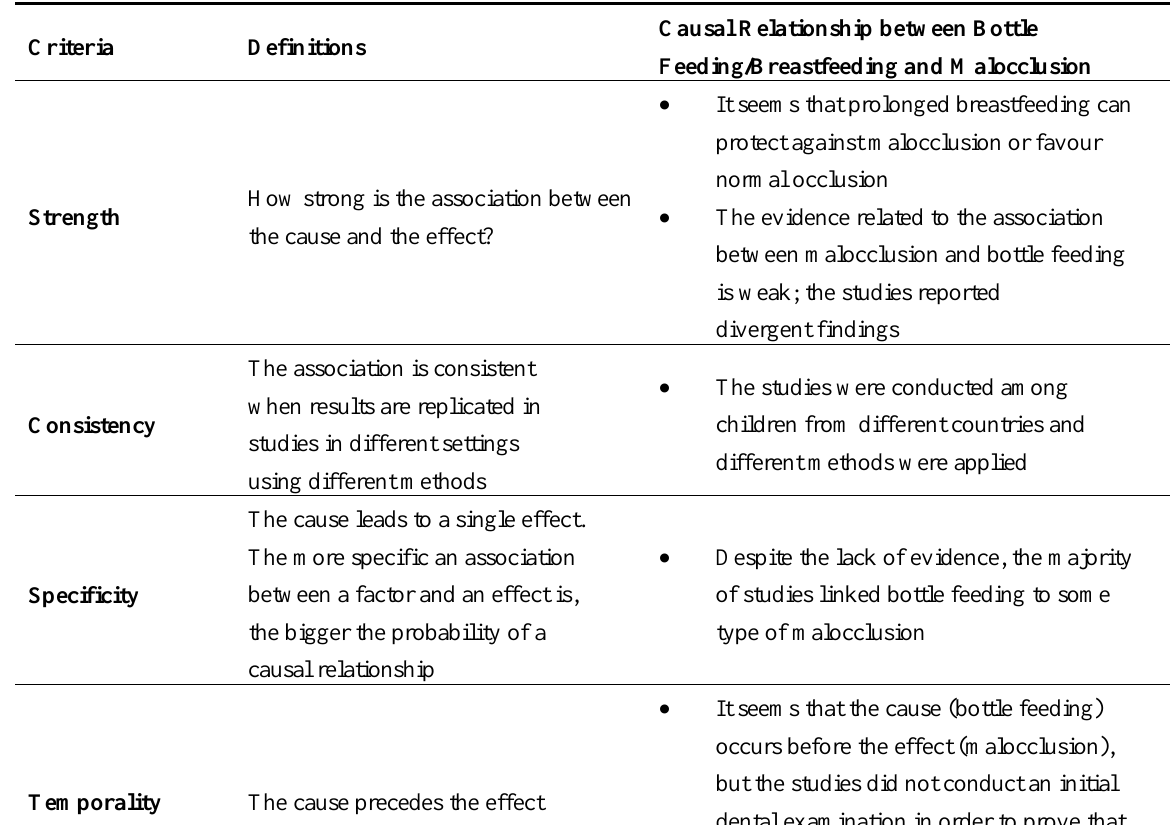
Table 3. Hill’s criteria of causation applied to malocclusion and its association with breastfeeding and bottle